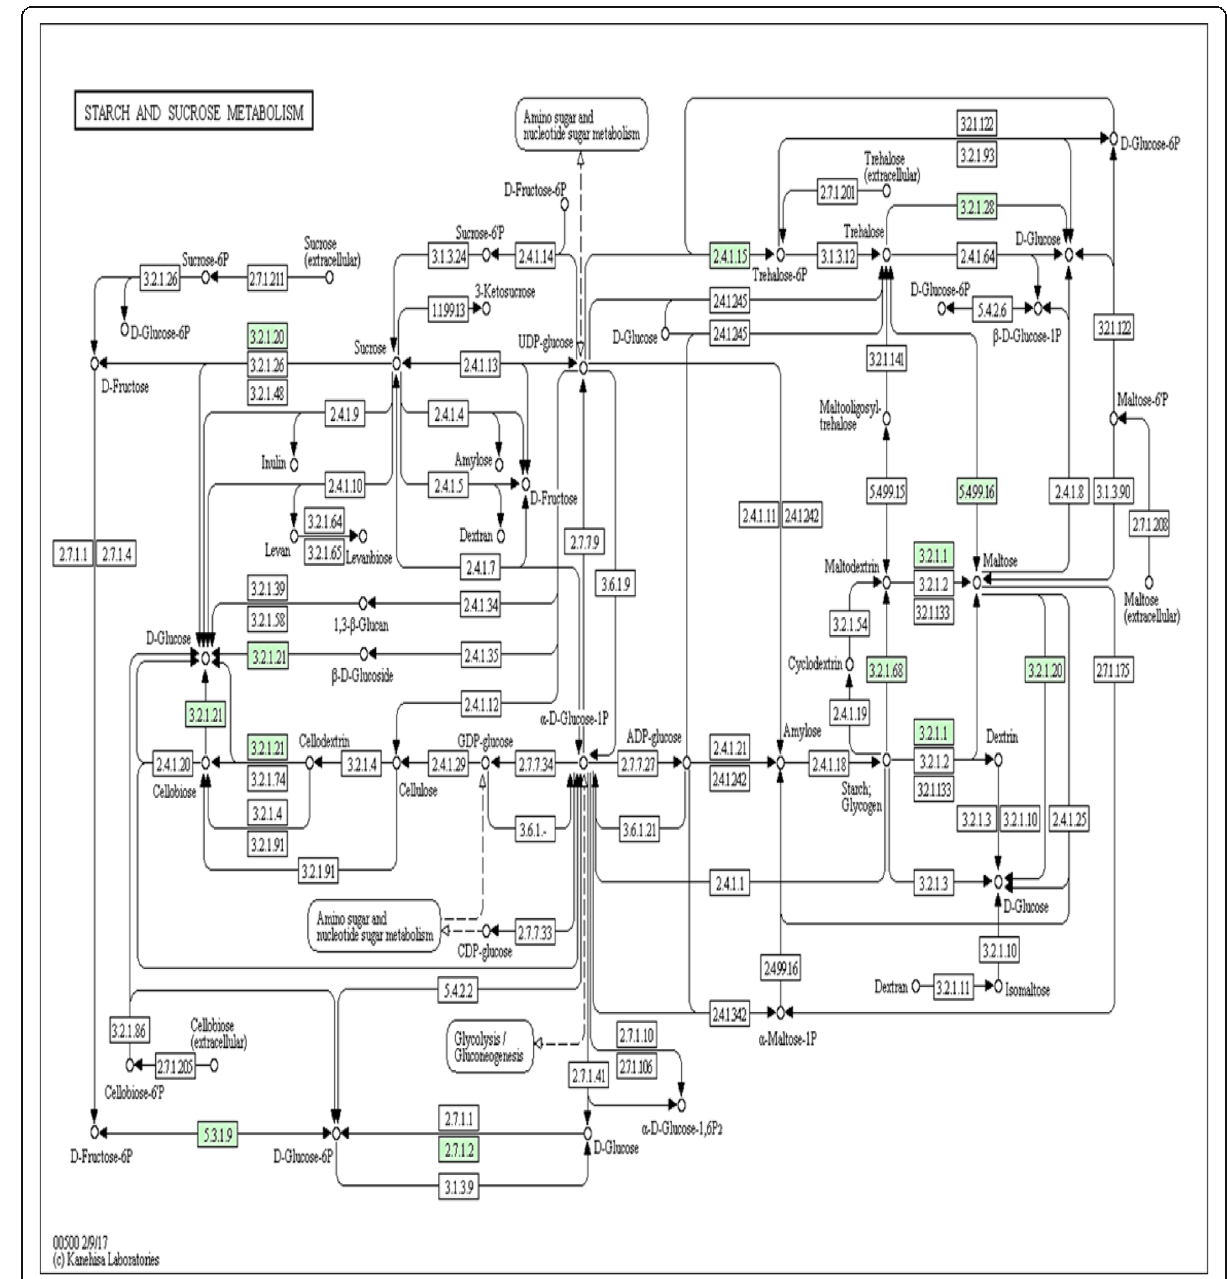
Fig. 4 Pathway for starch and sucrose metabolism performed using the KEGG pathway in KEGG Orthology. EC numbers in green are the enzymes identified in AB1